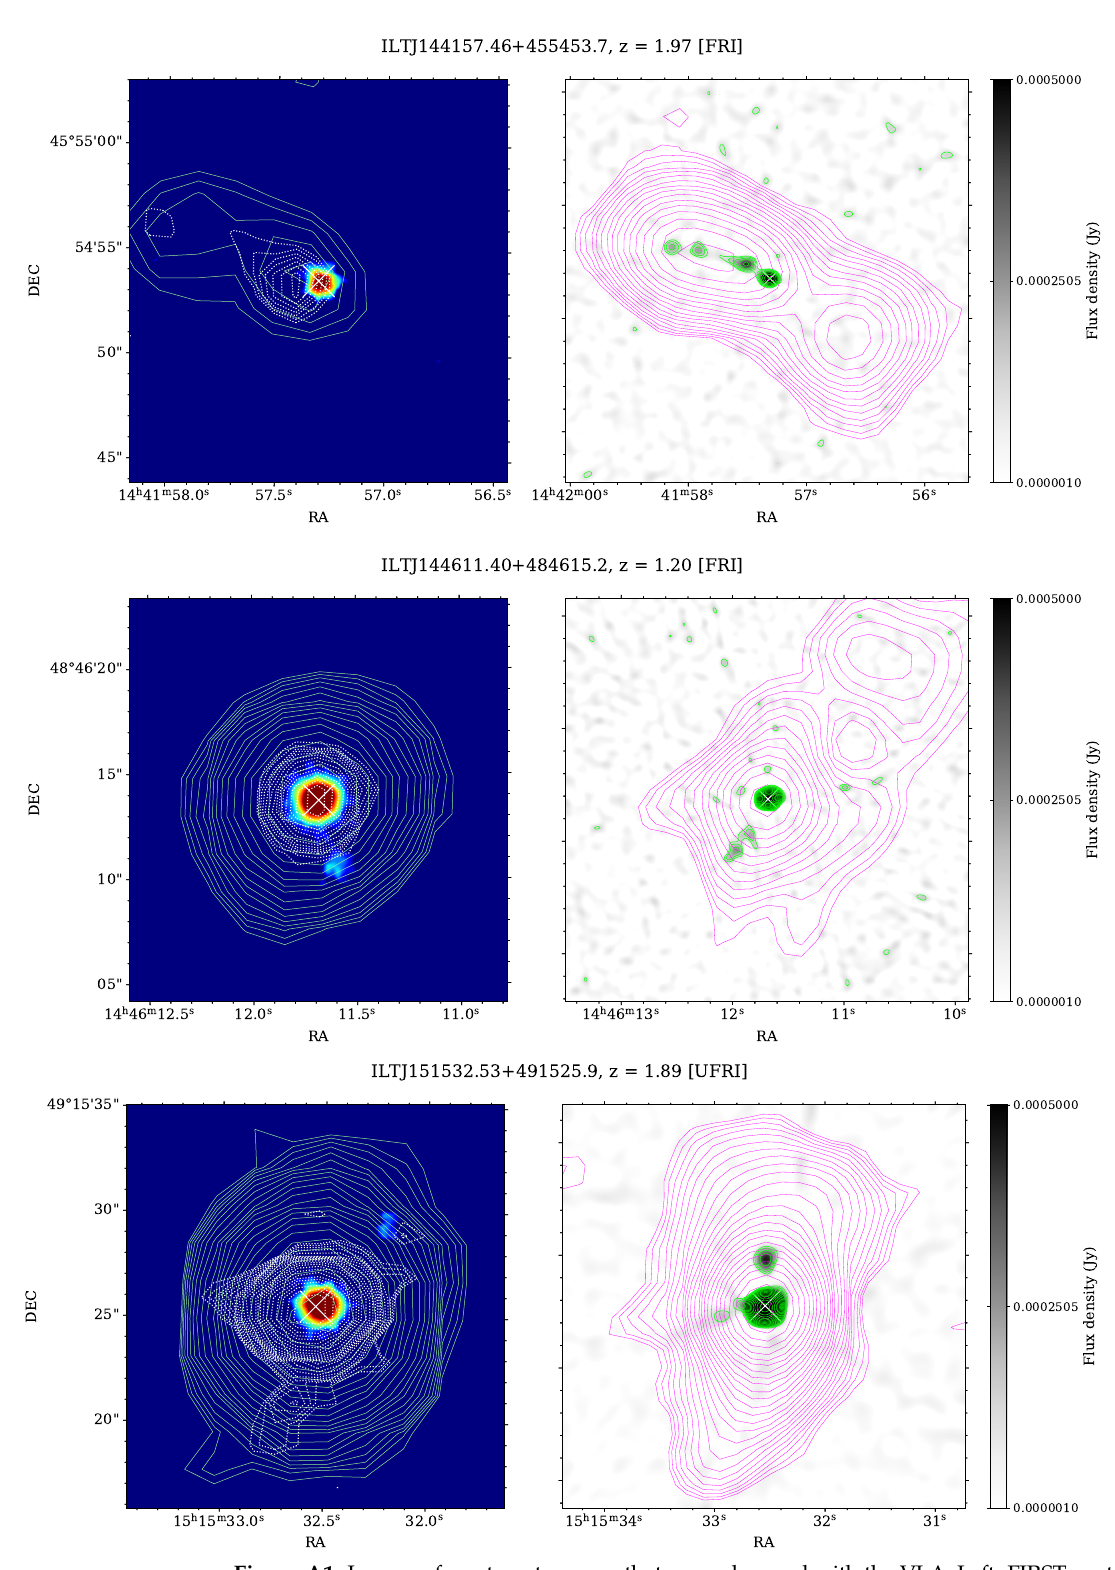
Figure A1. Images of our target sources that were observed with the VLA. Left: FIRST contours (light- green), the Very Large Array Sky Survey (VLASS) contours (white dotted) on PanSTARRS images (colour). Right: VLA contours (green), LOFAR contours (magenta) on VLA images (gray). The red ellipse in the right panel of the first raw shows the VLA beam. FIRST, VLASS, LOFAR and VLA contours denote the surface brightness levels starting at 3 σ and increasing at various powers of 3 σ , where σ denotes the local root-mean-square (RMS) noise in each map. Crosses show the position of the optical